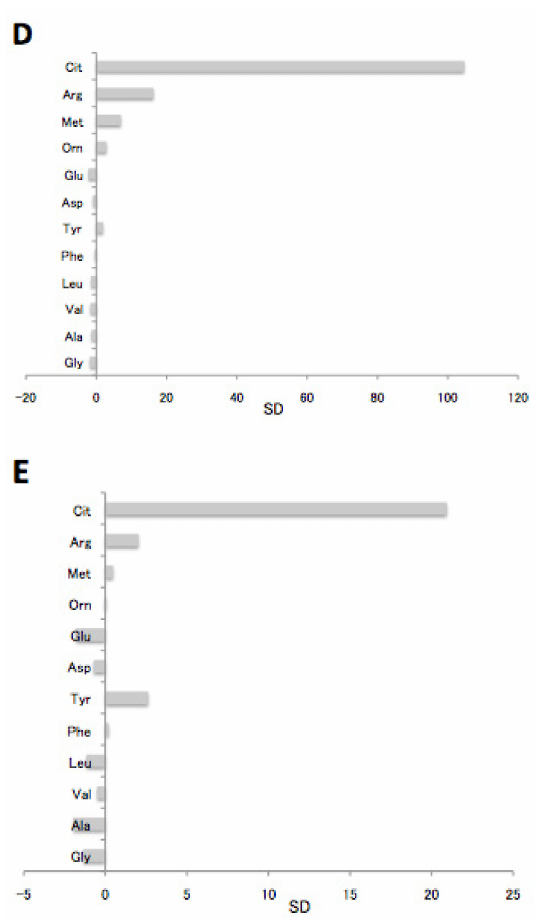
Figure 1. Characteristics of aminograms between patients with missed NICCD and one patient who was NBS-positive. The zero and numbers indicate the average and SD of the neonatal population ( n = 16360). A, B, C, D, and E: patients 2, 3, 9 (day 5), 9 (day 60), and 13 (NBS positive), respectively. Cit, citrulline; Arg, arginine; Met, methionine; Orn, ornithine; Glu, glutamic acid; Asp, aspartic acid; Tyr, tyrosine; Phe, phenylalanine; Leu, leucine+isoleucine, Val, valine; Ala, alanine; Gly,